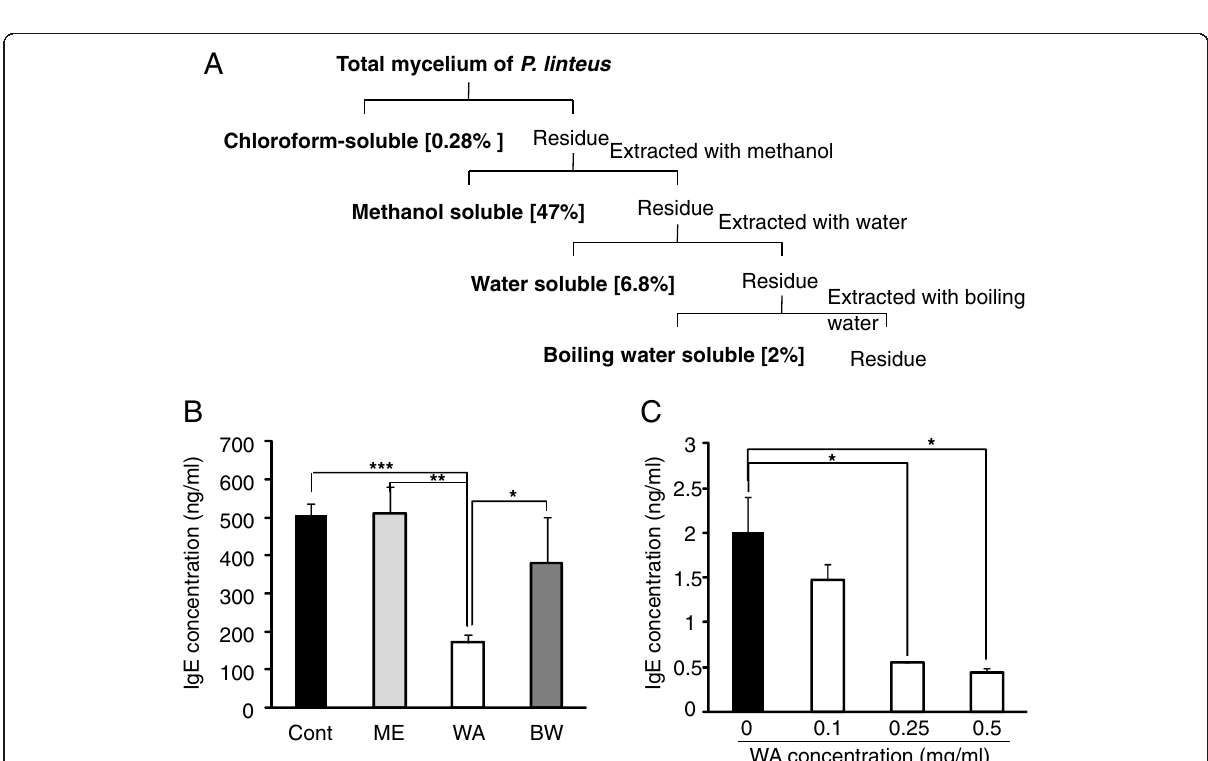
Figure 2 Water soluble extract of P. linteus (WA) treatment reduces IgE secretion by B cells. ( A ) Dried mycelium of P. linteus was extracted sequentially with chloroform, methanol, water and boiling water and then the fractions were freeze-dried resulting in a powdered extract. The yield of each fraction was indicated in the bracket. ( B ) The effect of each extract of P. linteus , ME (methanol soluble fraction), WA (water soluble fraction), BW (boiling water soluble fraction) on the secretion of IgE from U266B1 cell line was measured by ELISA. ( C ) B220+ B cells were isolated from lymph nodes and spleen of BALB/c mice. These primary B cells were stimulated with LPS (10 μ g/ml), IL-4 (5 ng/ml) and various concentrations of WA for 72 hrs and IgE level was measured by ELISA. Error bars indicated S.D. One (*), two (**) and three asterisk (***) indicates P<0.05, P<0.005, P<0.001, respectively. Data are representative of three independent